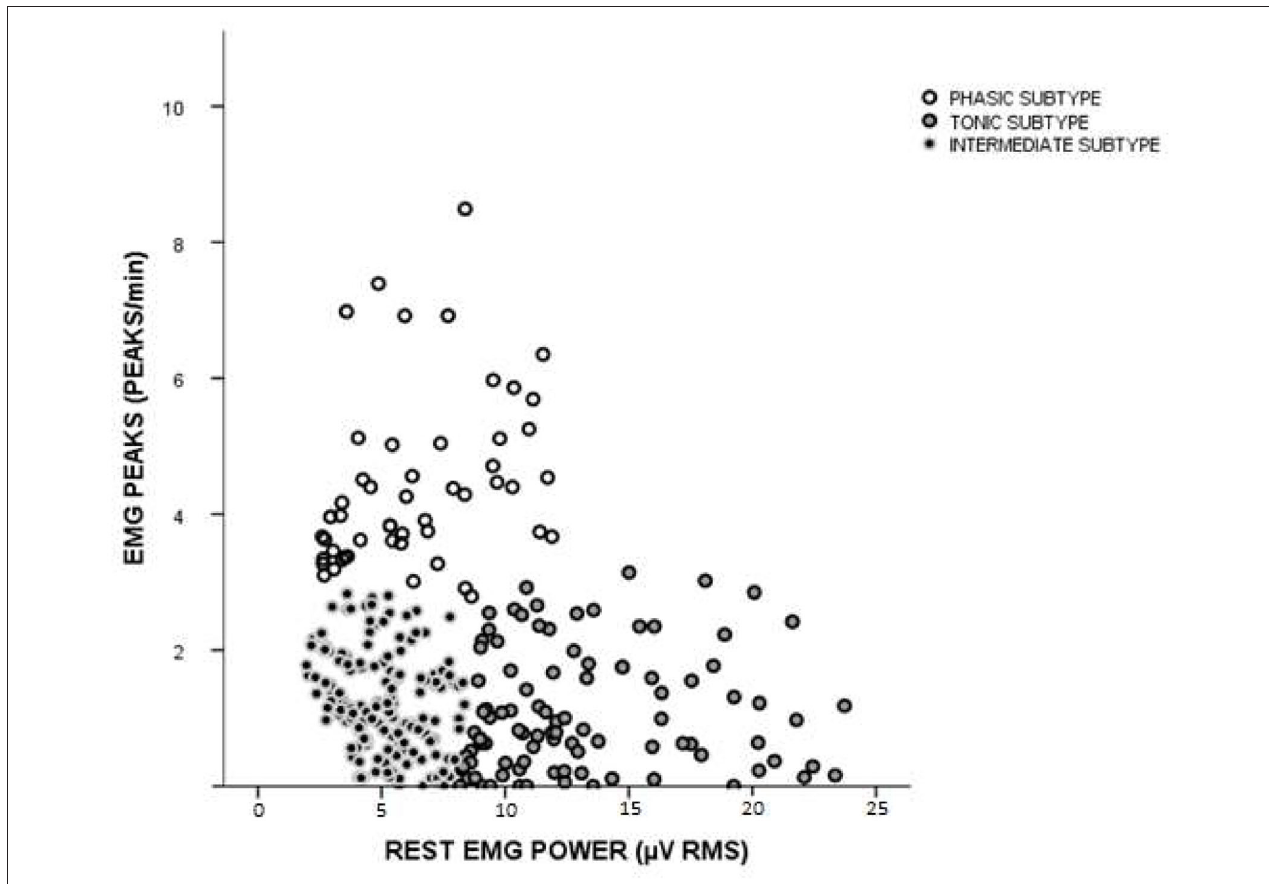
FIGURE 3 | Cluster analysis of individuals with awake bruxism. Three clusters emerged from analysis: phasic (increased EMG peaks/min and less rest muscle tonus), tonic (increased rest muscle tonus and decreased EMG peaks/min), and an intermediary group.